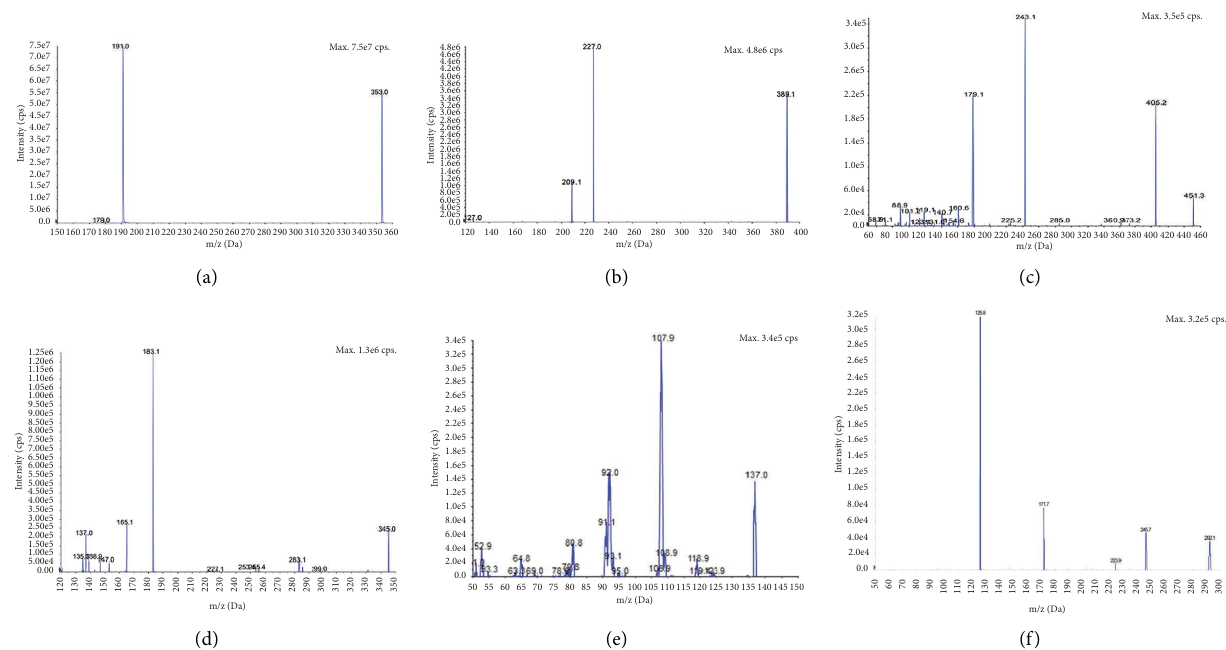
Figure 3: Mass spectrograms of chlorogenic acid (a), loganin (b), morroniside (c), aucubin (d), protocatechuic aldehyde (e), and tinidazole (IS)